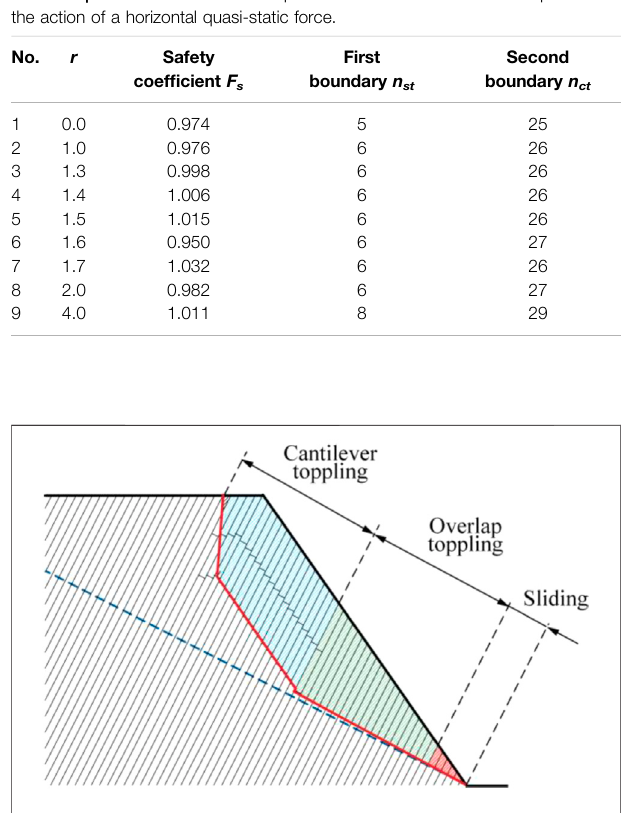
FIGURE 9 | Failure surface and instability zoning of the anti-dip rock slope in southern Anhui (cantilever toppling zone; overlap toppling zone; sliding zone).